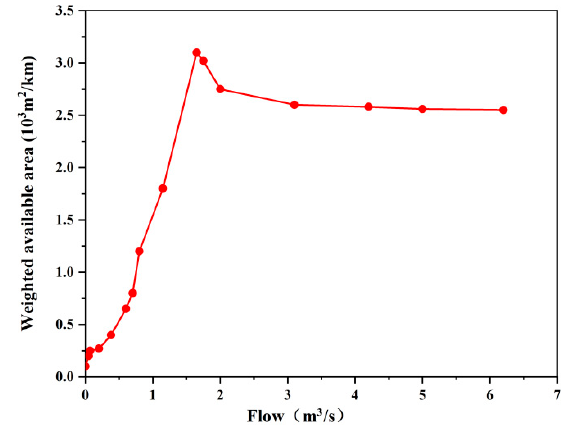
Figure 9. Weighted available area of the study area vs. flow.